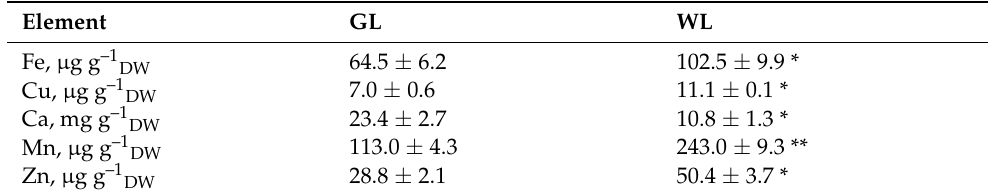
Table 2. Content of Fe, Cu, Ca, Mn, and Zn in GL and WL of P. zonale plants grown under optimal